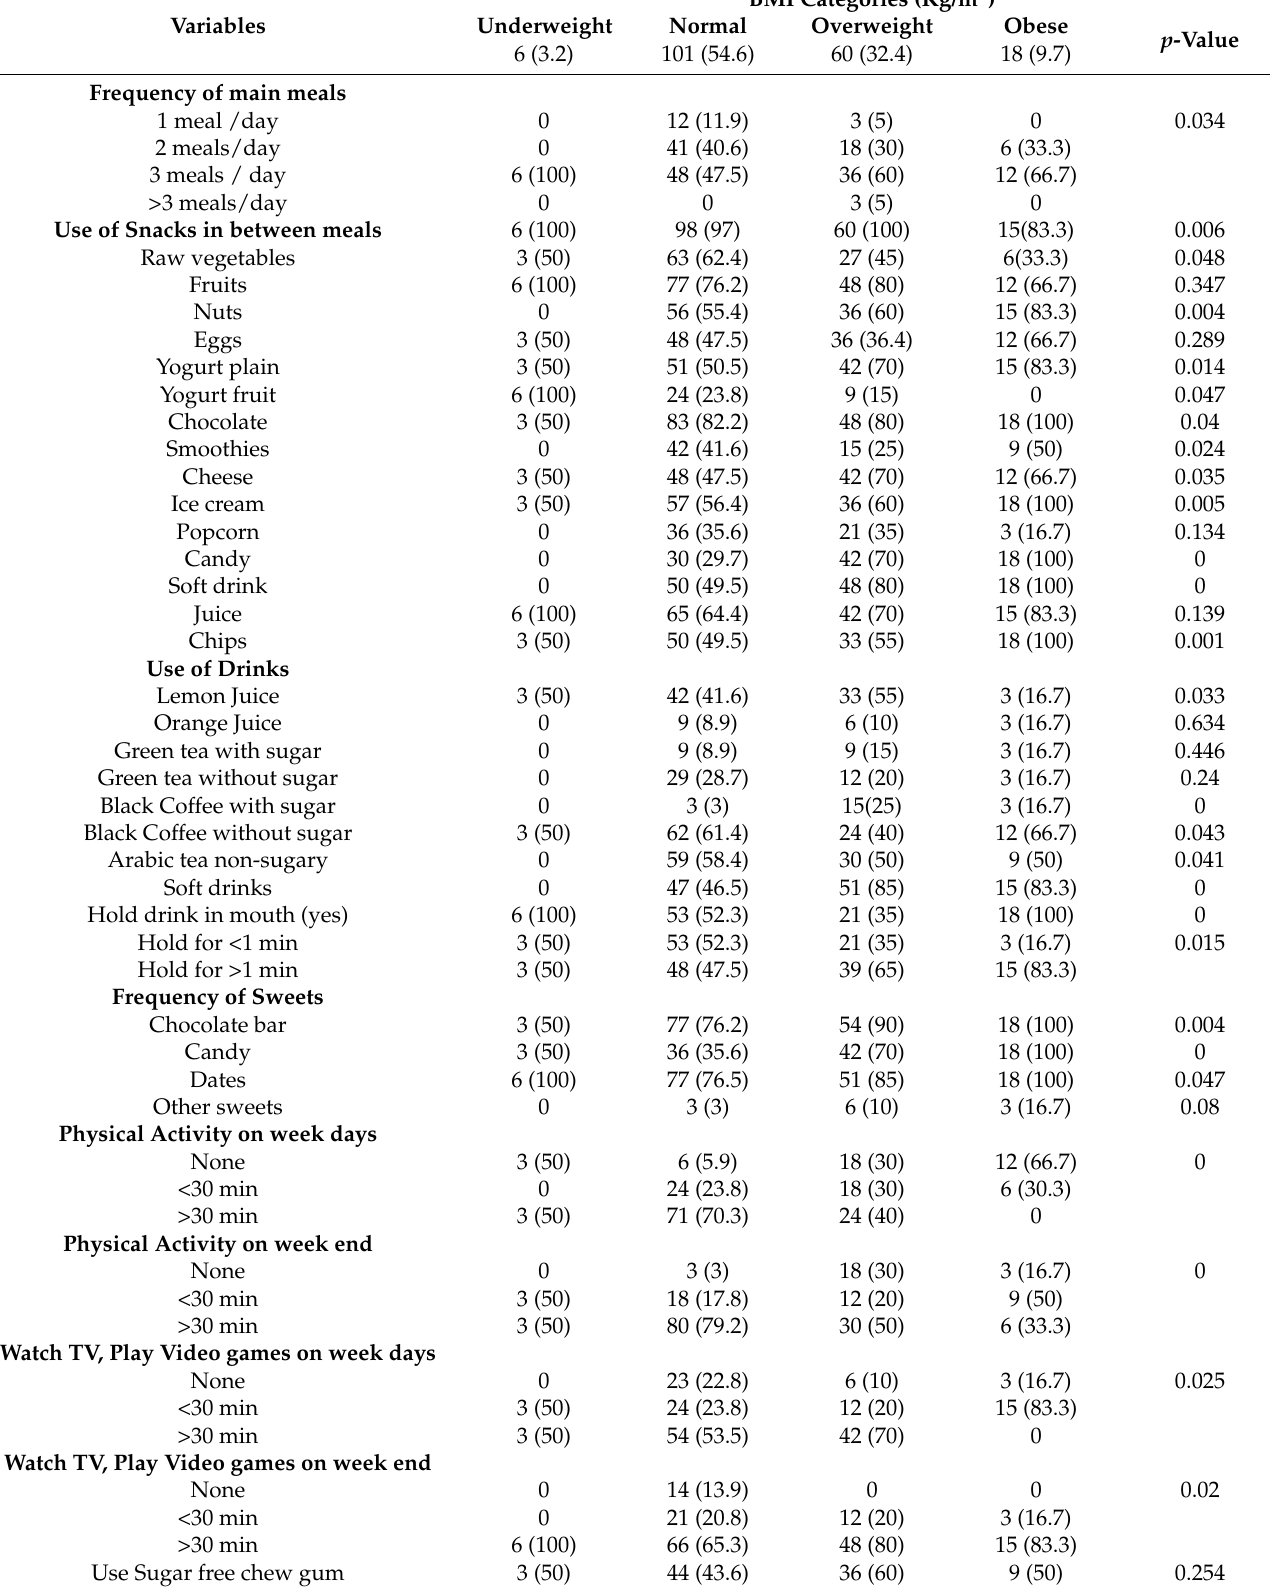
Table 2. Distribution of Diet and Physical Activity variables [ n (%)/(Mean ± SD) ] among the BMI